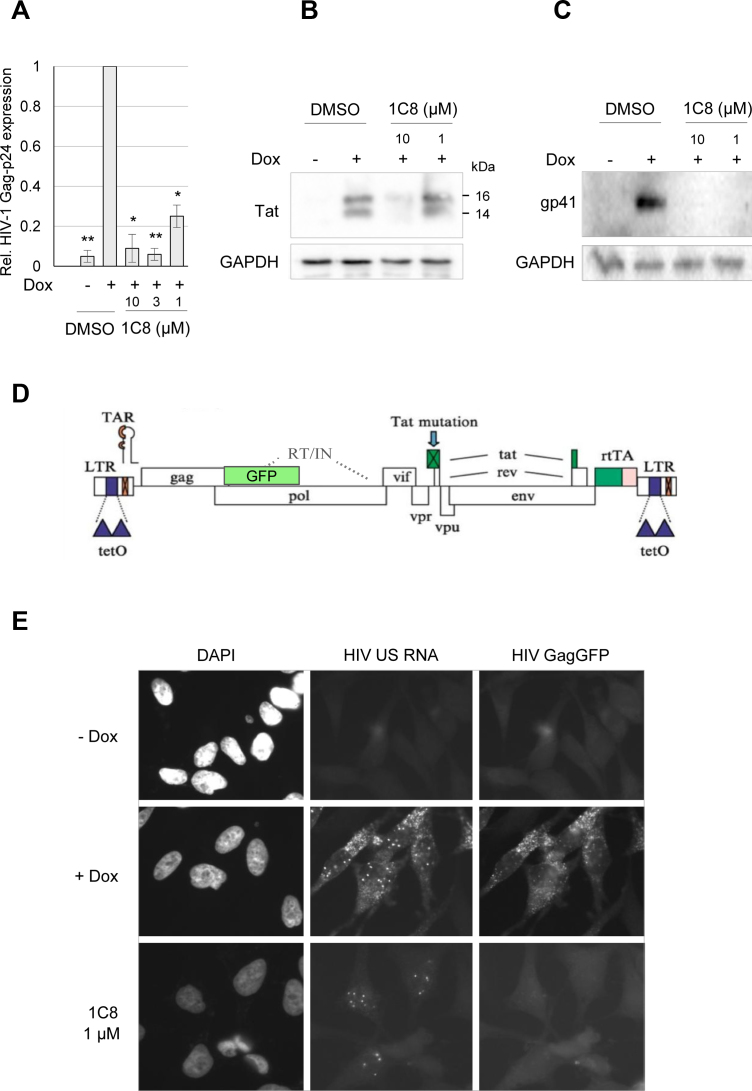
Impact of 1C8 on HIV-1 protein expression and localization of unspliced viral pre-mRNA. HeLa-HIV cells were treated with either DMSO or 1C8 at the indicated doses for 4 h prior to addition of doxycycline (Dox) to induce provirus expression. Twenty-four hours after Dox addition, cells were harvested and viral protein levels were assessed by ELISA for HIV Gag-p24 (A) or immunoblots for viral proteins Tat (B) and Env-gp41 (C). In panel A, asterisks represent significant P values (two-tailed Student's t test) comparing the means between 1C8-treated samples and their respective controls; *P < 0.05, **P < 0.01 and ***P < 0.001. (D) Structure of the HIV-1 provirus used to generate the HeLa cell line with the GagGFP fusion. The provirus has elements (TetO sites, rtTA) required for regulation by doxycycline (Dox). (E) Effect of 1C8 on HIV-1 unspliced (US) RNA localization. Cells were incubated in the absence (–) or the presence (+) of Dox for 24 h, then fixed, stained with DAPI and imaged using a Leica DMR epifluorescent microscope. HeLa HIV GagGFP cells were treated with either DMSO or 1C8 (1 μM) for 4 h prior to addition of Dox to induce provirus expression. Twenty-four hours after Dox addition, cells were fixed and HIV-1 US RNA localization was determined by in situ hybridization. Magnification 600×.